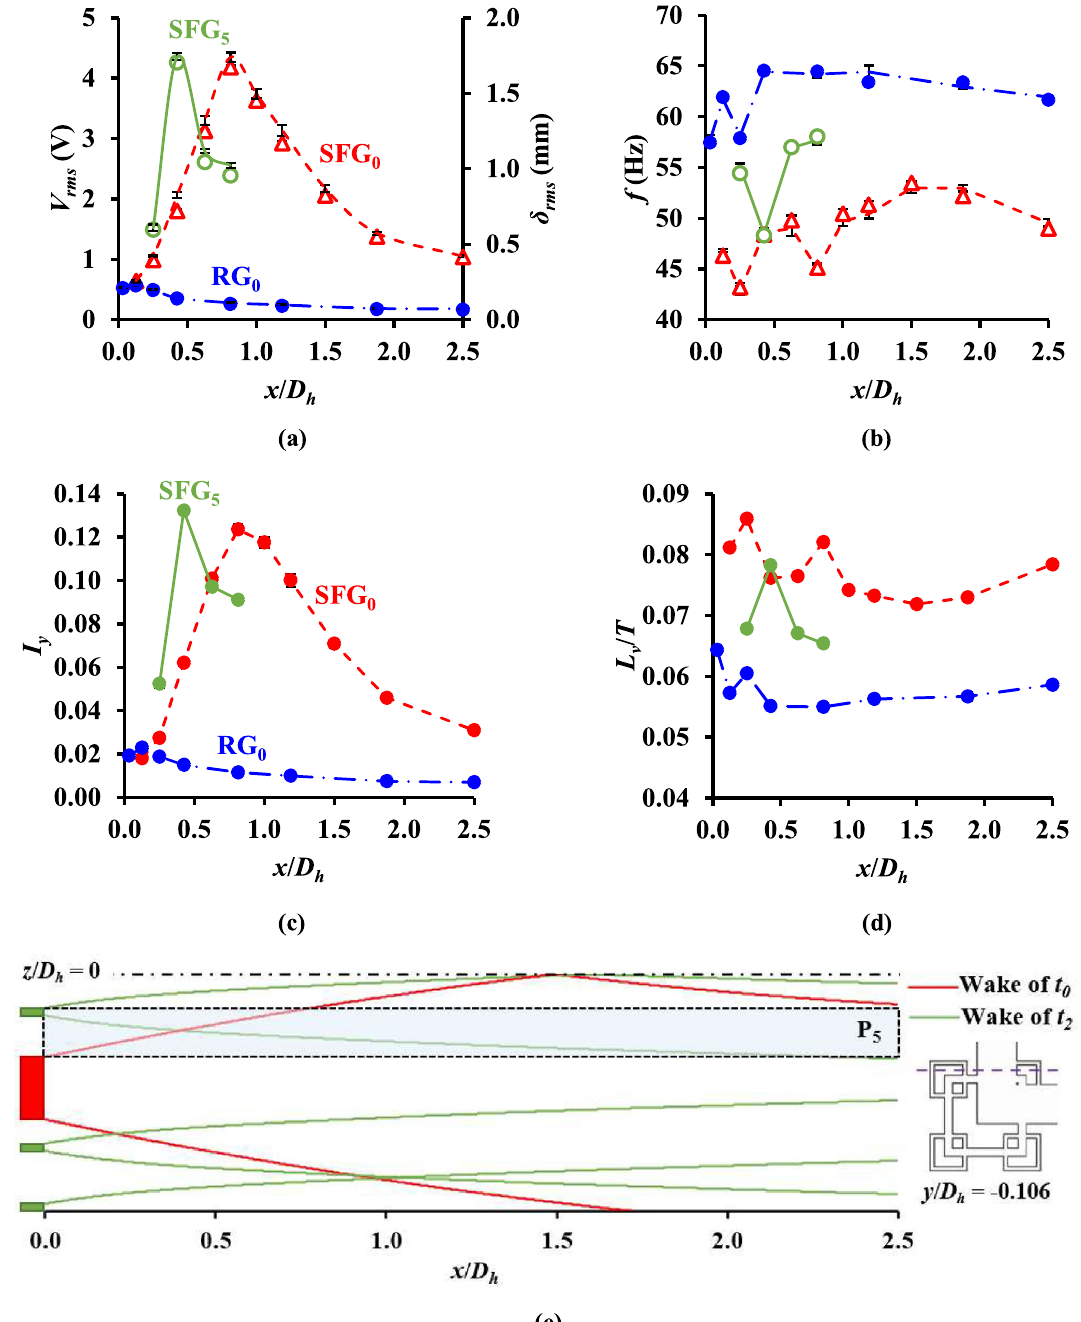
Figure 5. ( a ) RMS of experimentally recorded piezoelectric output voltage V rms and tip deflection δ rms , as well as ( b ) the corresponding dominant frequency of voltage signal f V and thin-film flapping f δ , at different streamwise distances x / D h along the leeward of SFG( P 0 , P 5 ) and RG centerline [ note : Symbol denotes piezoelectric measurements and line the camera detection]. Grid-induced equivalent ( c ) turbulence intensity I y and ( d ) lateral integral length scale L v /T against x / D h . ( e ) Interactions between wakes generated by the SFG bars at y / D h = −